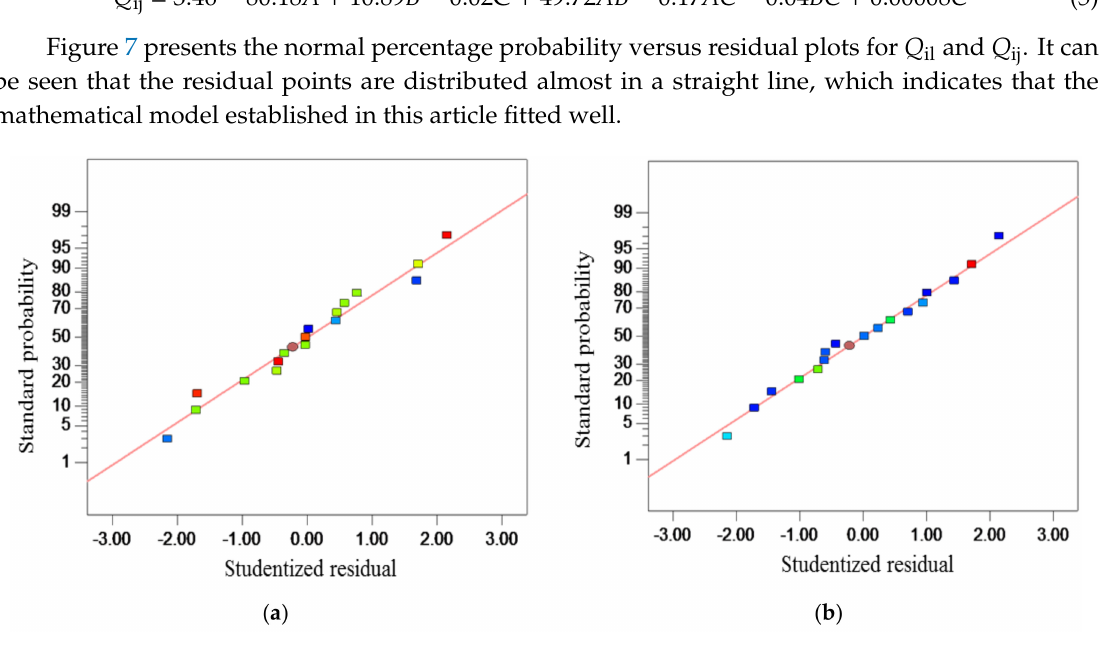
Figure 7. Normal plots of residuals for the responses. ( a ) Q il ; ( b ) Q ij